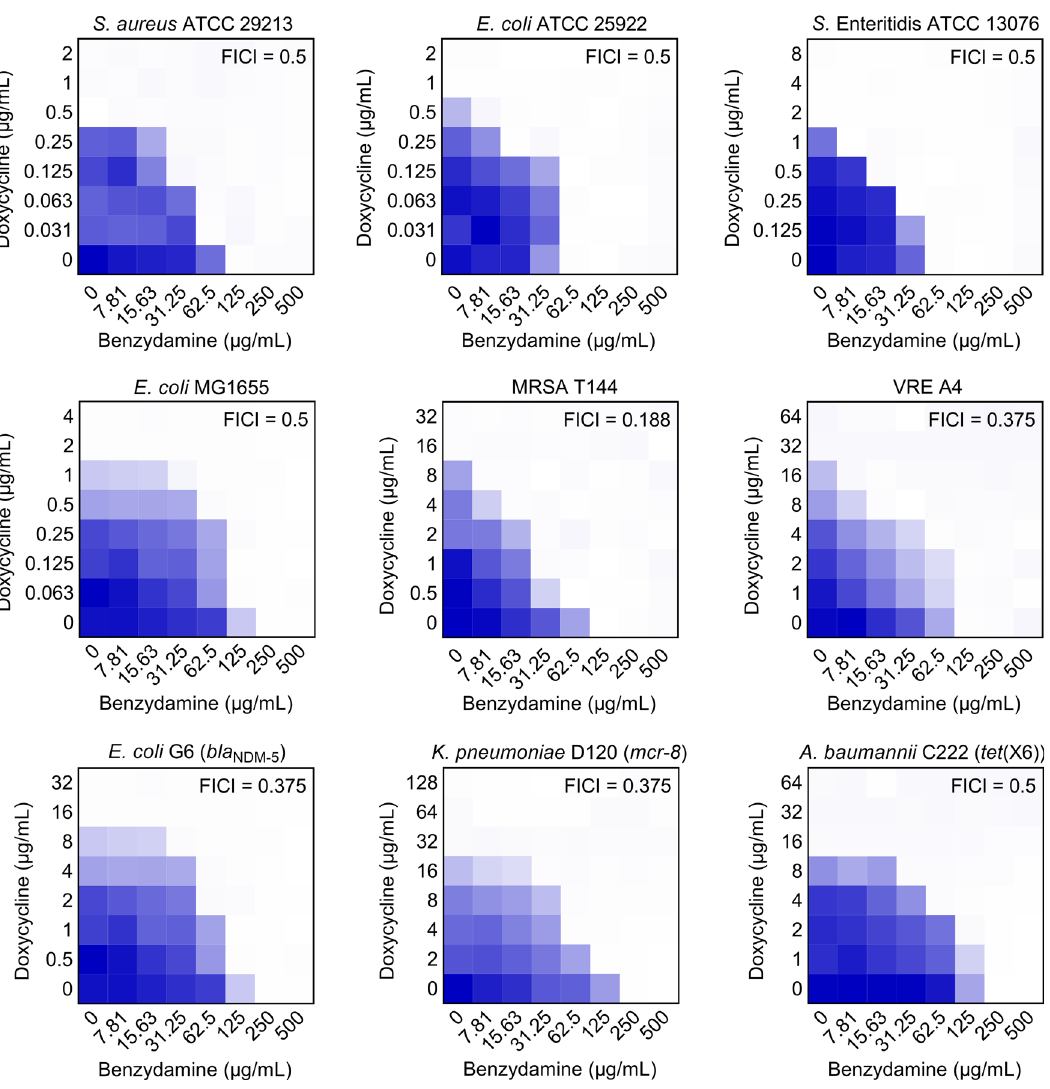
Fig. 1 Synergistic activity between benzydamine and doxycycline against drug-susceptible and -resistant bacteria by checkerboard assay, related to Supplementary Table 3. Dark blue regions represent higher cell density. Data represent the mean OD 600 nm of two biological replicates. Synergy is de fi ned with FIC index ≤